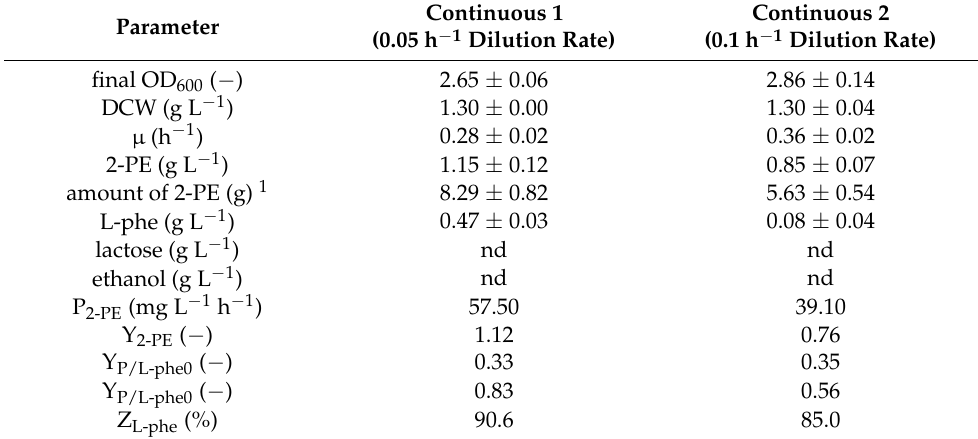
Table 4. Parameters of 72 h continuous cultures of K. marxianus WUT240 producing 2-PE in WP2 medium at 30 ◦